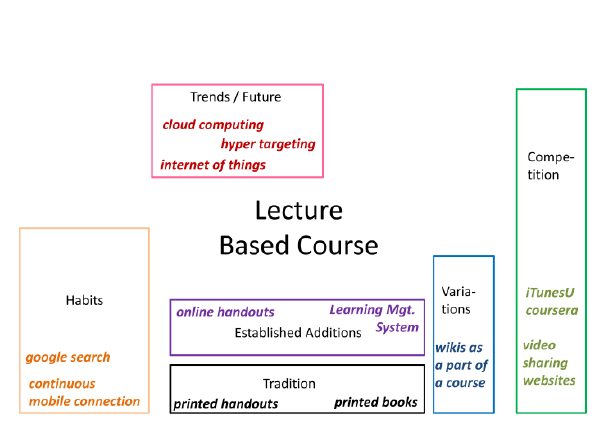
Figure 16. Usage of media in relation to a